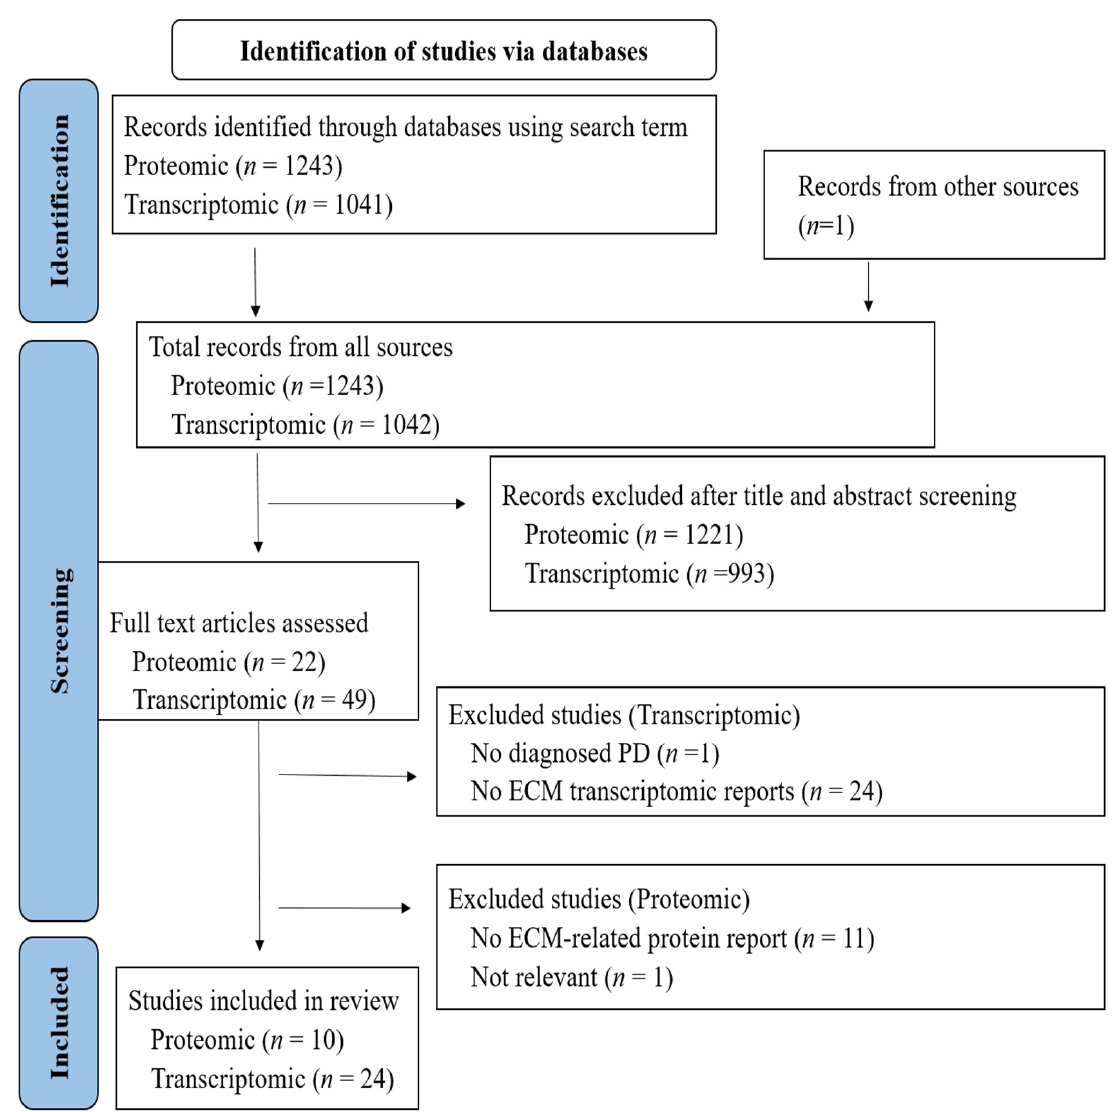
Figure 1. Preferred reporting items for systematic reviews and meta analyses (PRISMA) flow diagram of the search strategy.